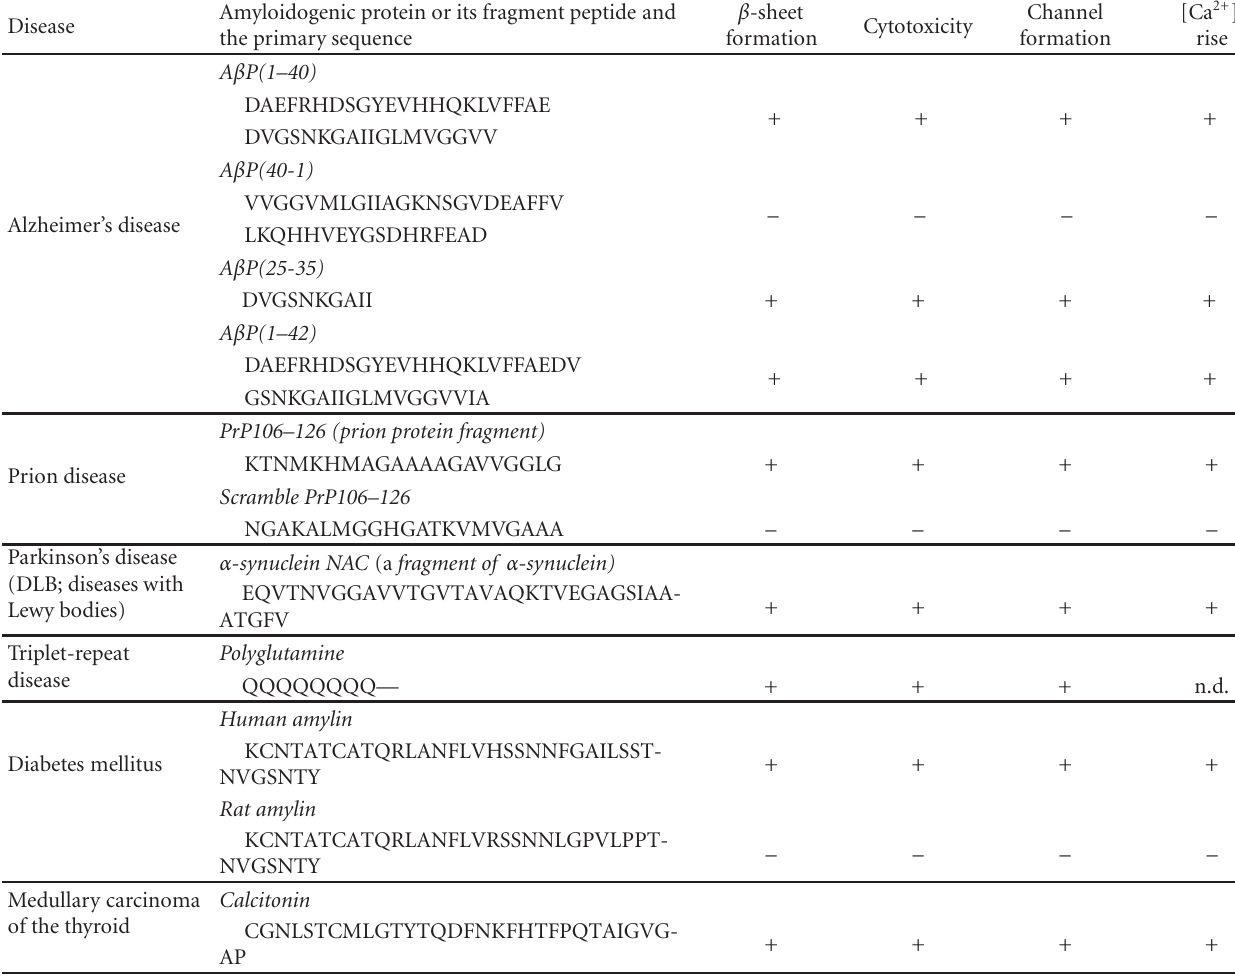
Table 1: Characteristics of amyloidogenic proteins and the related